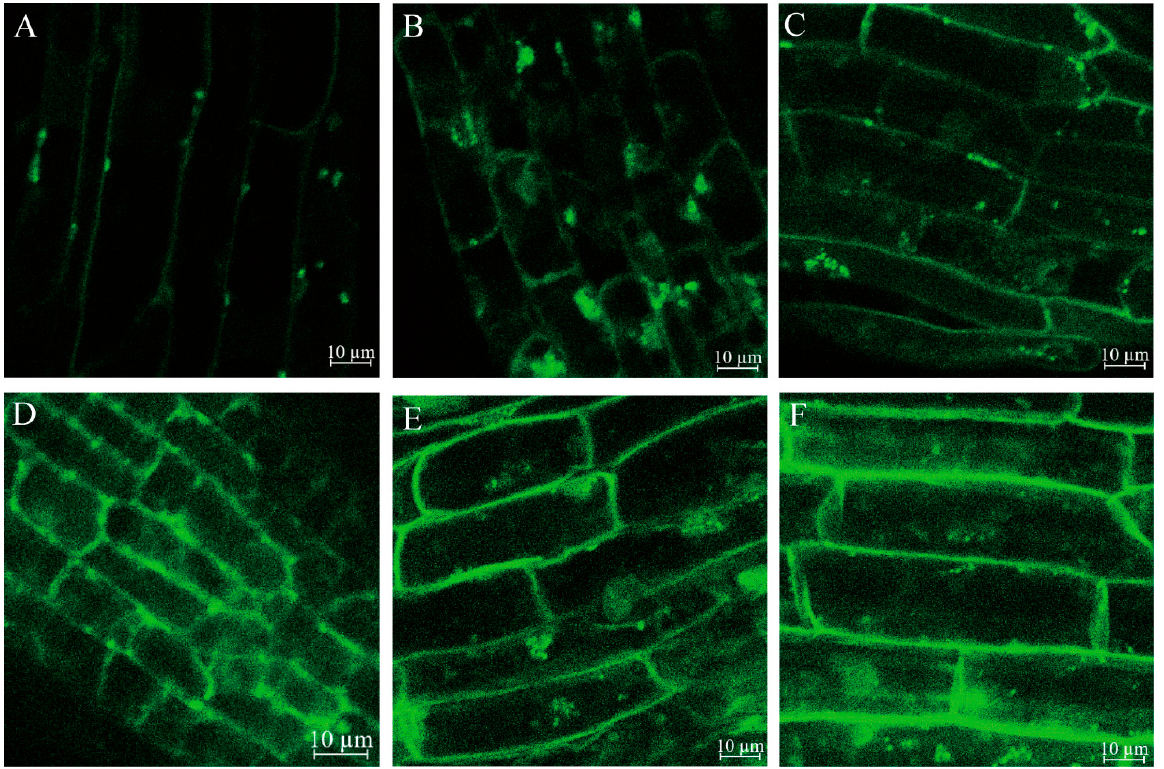
Figure 9. Calcium imaging in different treatments. ( A ) Control treatment, ( B ) 6 h post 6% PEG treatment, ( C ) 12 h post 6% PEG treatment, ( D ) 24 h post 6% PEG treatment, ( E ) 48 h post 6% PEG treatment, and ( F ) 120 h post 6% PEG treatment. The scale bar is 10 μ m.